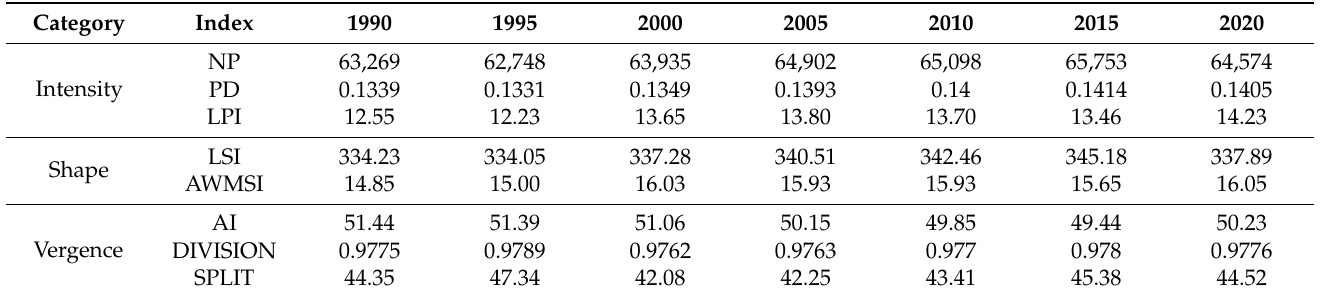
Table 3. Results of the landscape pattern analysis of paddy